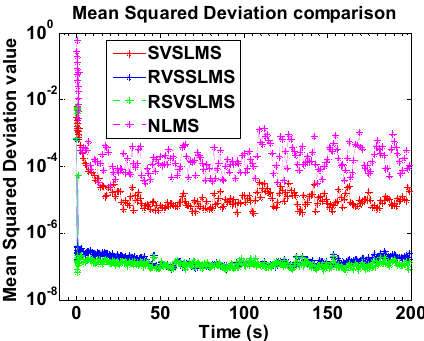
Figure 25. Comparison of mean squared deviation for the NLMS technique, existing variable step-size LMS and new regularized sigmoid variable step-size LMS techniques. The data processing was carried out in a single set with the time range limited to 200 s. The plot shows a possible similarity in the data processing quality between the two regularized processing techniques, with the RSVSLMS technique having a better consistency / continuity in the MSD value after convergence.